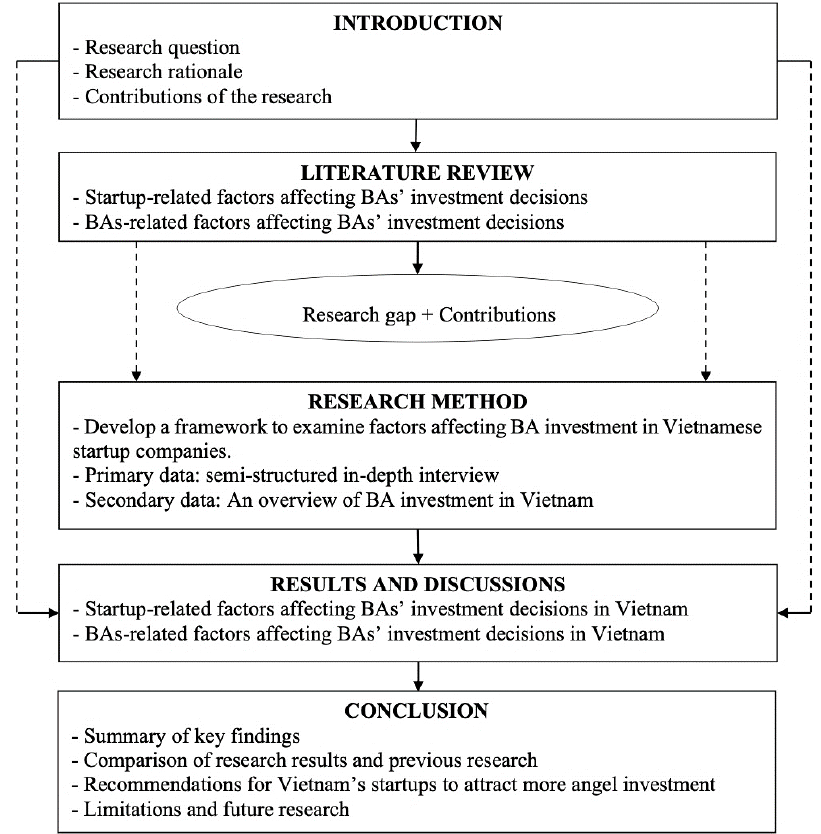
Figure 1. Flow chart of the research